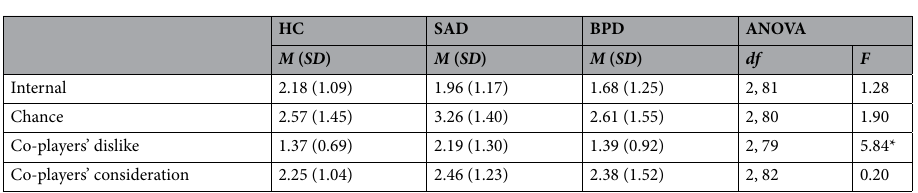
Table 2. Results for attribution of the increased frequency of social interaction. HC healthy controls, SAD social anxiety disorder, BPD borderline personality disorder. * p < 0.01.